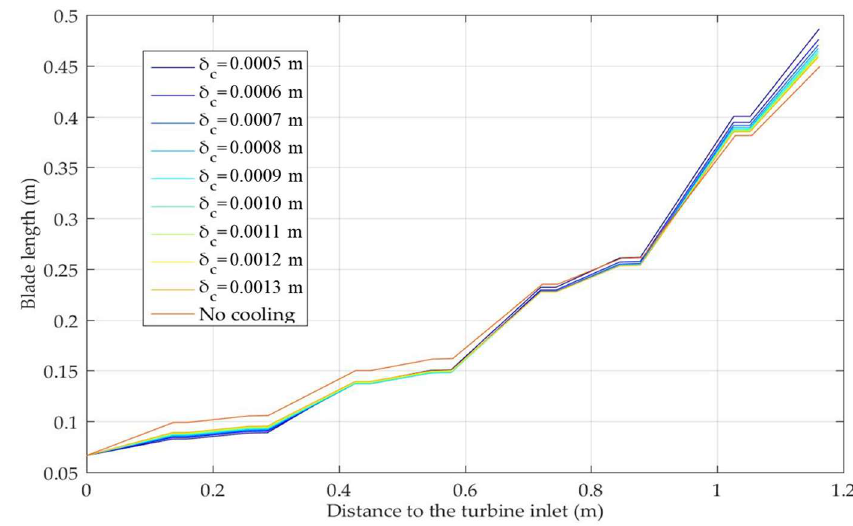
Figure 10. Structure of the turbine flow passage.